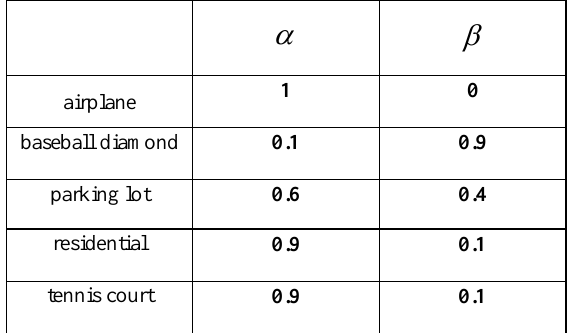
Table2. Weights used in similarity measure for each images